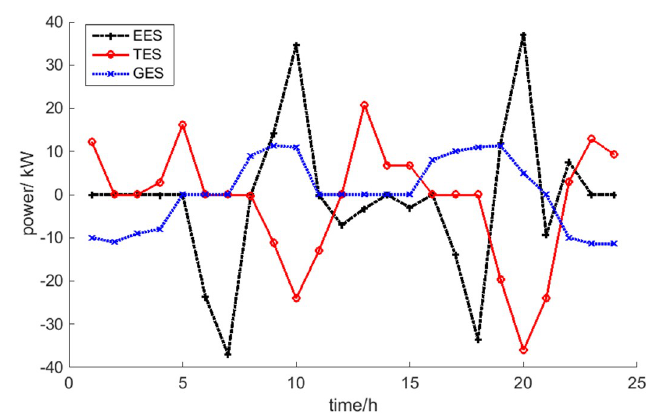
Figure 5. The output of each energy storage device. 503